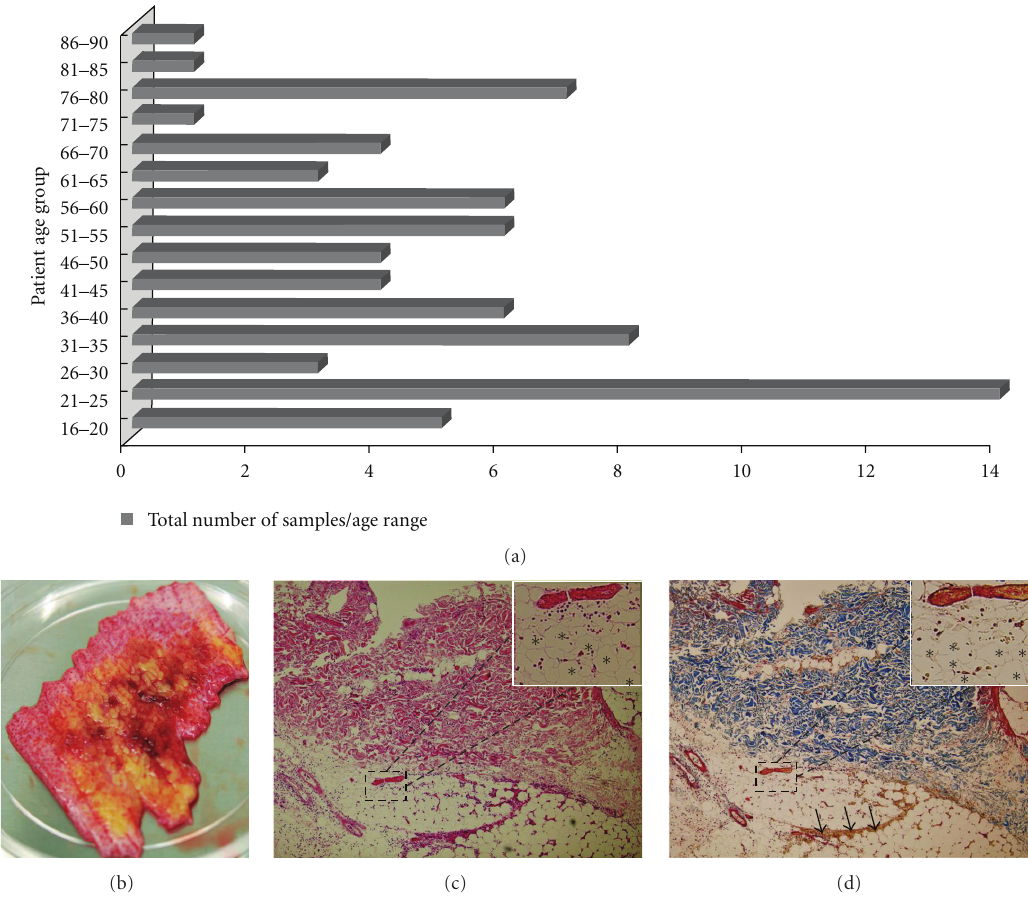
Figure 2: (a) Total number of discarded skin samples collected per age group for the patient population included in this study. (b) Discarded burn tissue. (c) Hematoxylin and eosin staining of burn tissue showing the loss of epidermal and dermal layers of the discarded burn skin. The inset figure is the magnified field of the section showing presence of collapsed blood vessel within the hypodermal layer (asterisks). (d) Masson’s trichrome stained adipose tissue sections of discarded burn tissue showing collapsed and viable hypodermis (arrows). The figure inset is the magnified field view of the viable hypodermis (asterisks). Original magnification: × 100 (c, d) and × 400 (figure